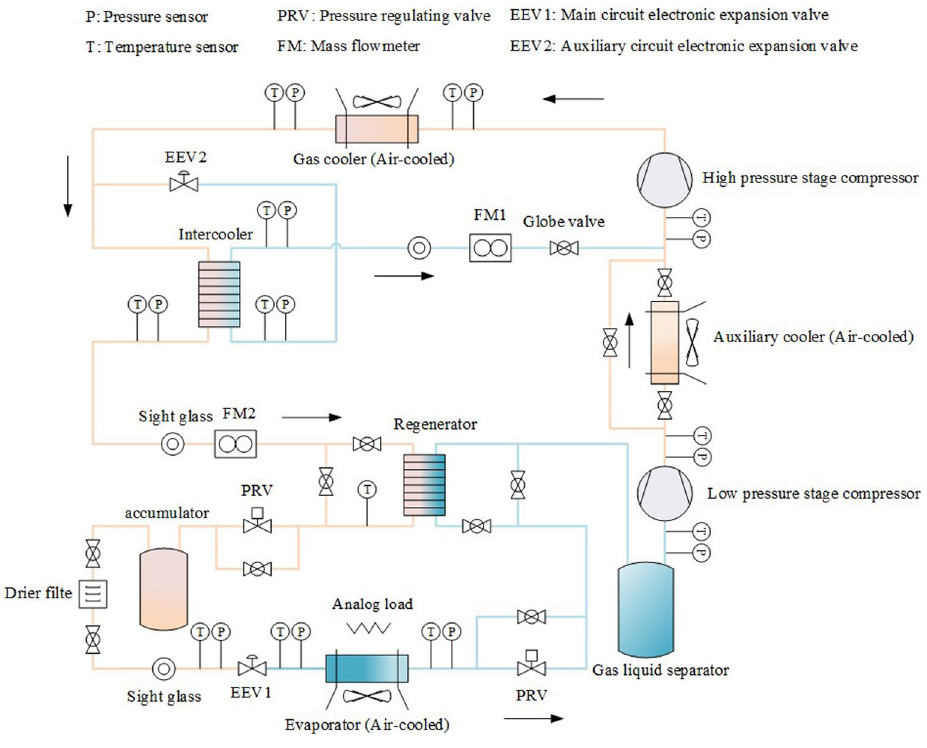
Figure 1. System schematic diagram of the CO 2 transcritical refrigeration experimental